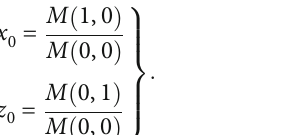
/ k = 1 ) and heterogeneous cases ( k v c